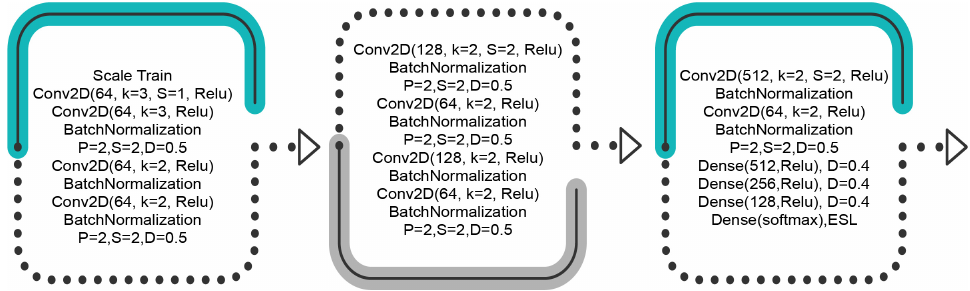
Figure 2. FER neural network configuration implementation (Phyton TensorFlow